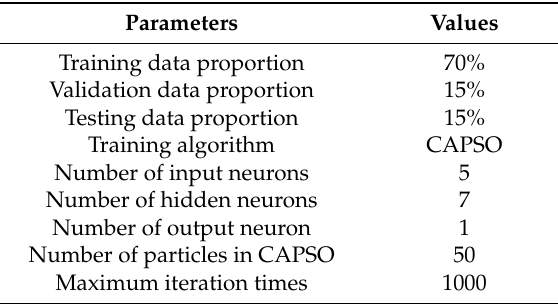
Table 3. Optimized model parameters.